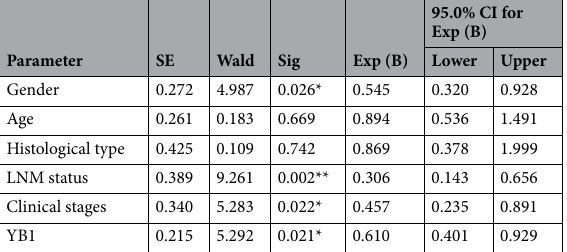
Table 3. Summary of multivariate of Cox proportional regression for overall survival in 410 cases of NPC. Multivariate analysis of Cox regression, * P < 0.05; ** P < 0.01. CI, confidence interval; Exp (β), odds ratio; LNM, lymph node